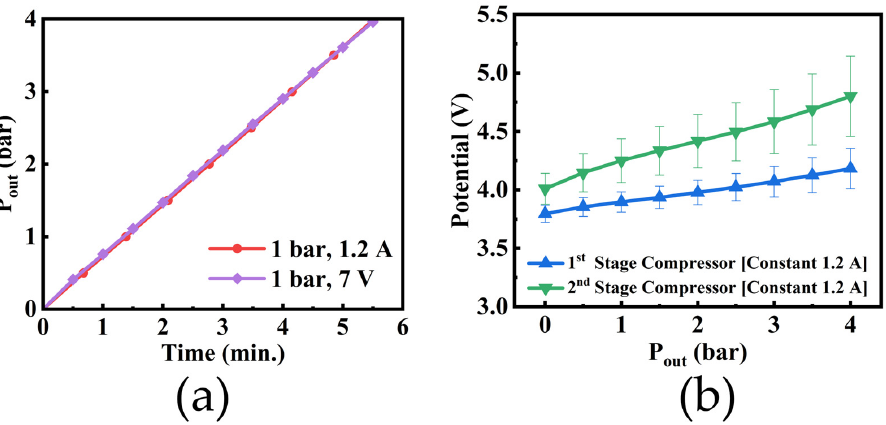
Figure 6. The DC–DP system, applying a constant current and voltage at an anode pressure of 1 bar. ( a ) Compression rate when a constant current or constant voltage is applied. ( b ) Voltage changes as a function of the cathode pressure when a constant current is applied.